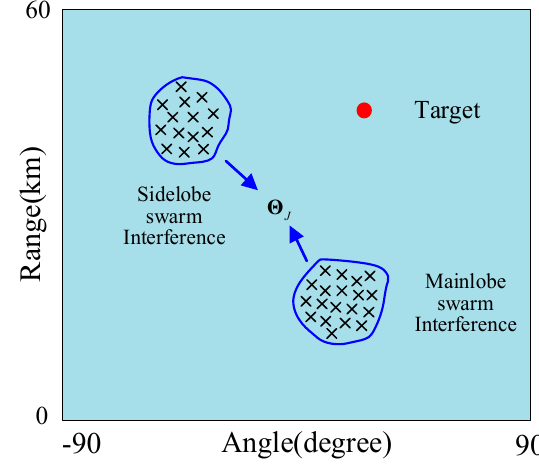
Figure 3. Swarm interference